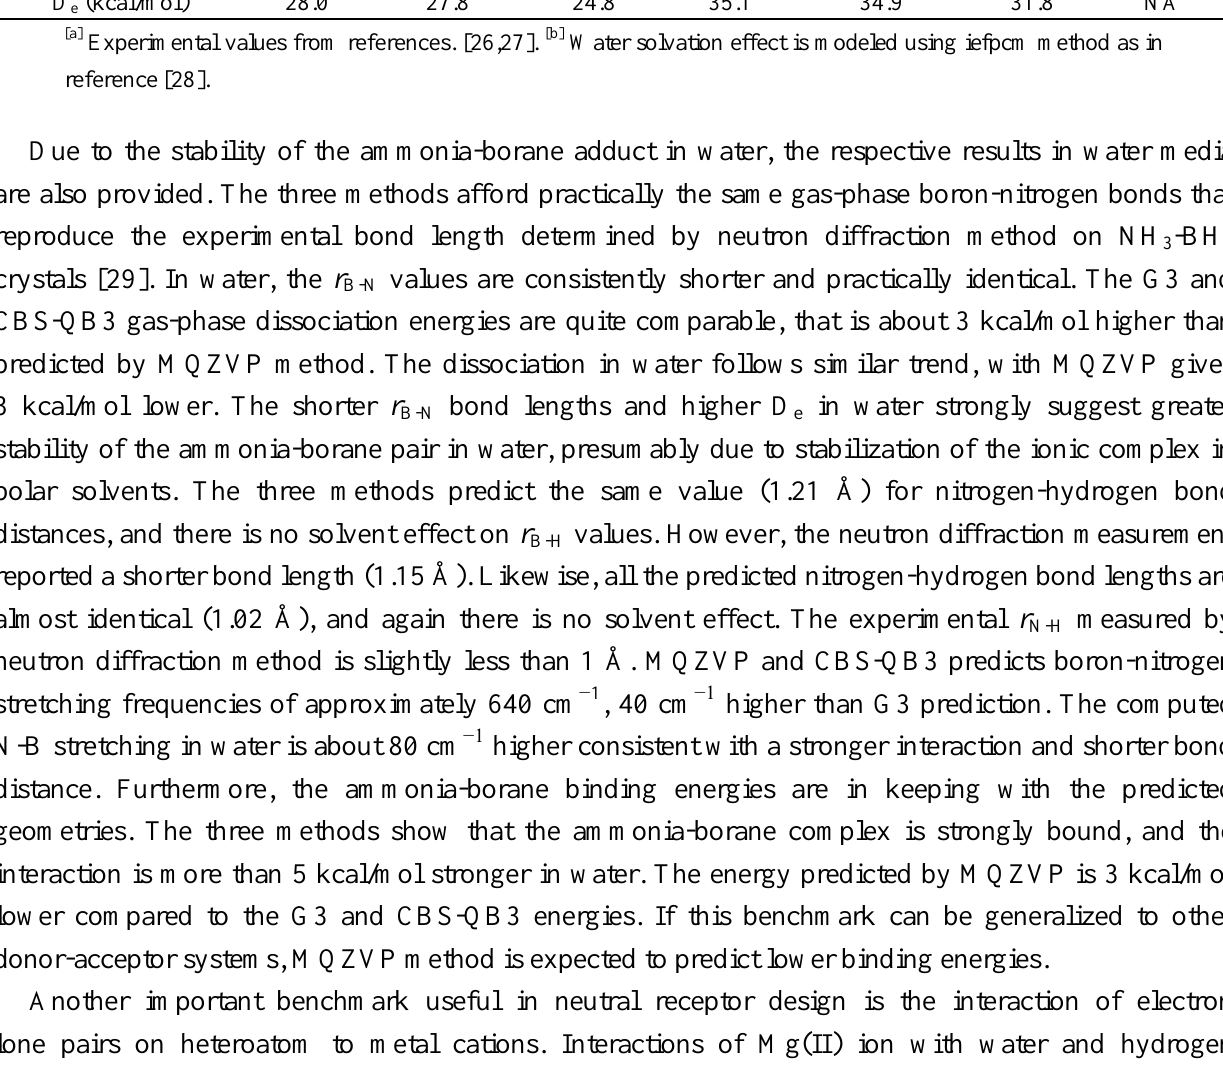
Table 2. Bond distances ( r ) and dissociation energies (D ) of ammonia-borane benchmark. e G3 CBS-QB3 MQZVP G3 CBS-QB3 MQZVP NH -BH Exptl [a] 3 3 Vac Vac Vac Water [b] Water [b] Water [b] B-N ( r , Å) 1.661 1.664 1.658 1.626 1.627 1.630 B-N B-H ( r , Å) 1.209 1.208 B-H N-H ( r , Å) 1.020 1.017 1.014 1.020 1.018 1.010 N-H B-N Freq (cm −1 ) 605.0 636.5 642.4 NA 722.4 NA NA D (kcal/mol) 28.0 27.8 24.8 e